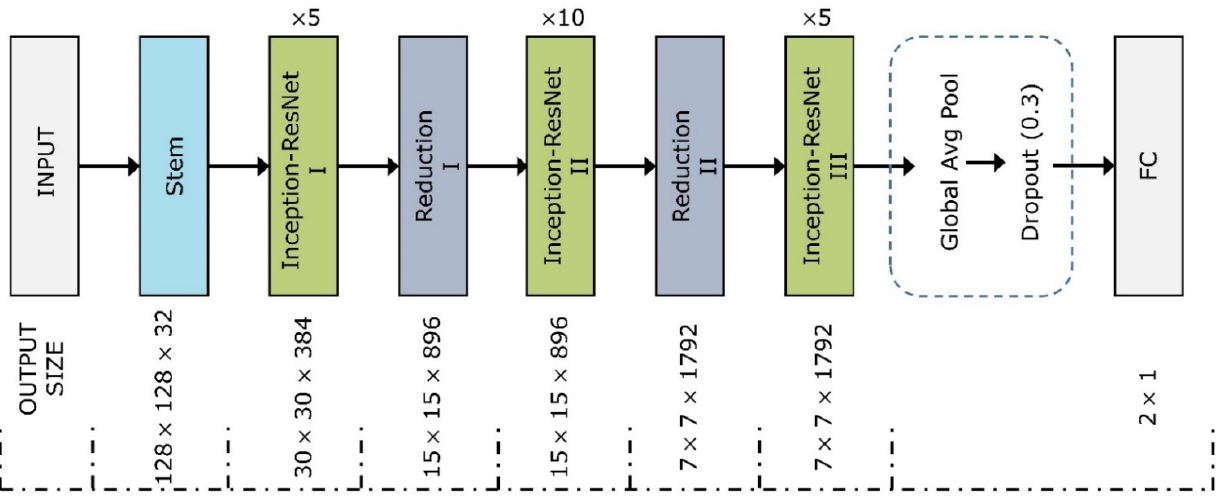
Figure 7. The architecture of the inception-ResNet. Abbreviations: FC—fully connected layer, Global Avg Pool—global average pooling.